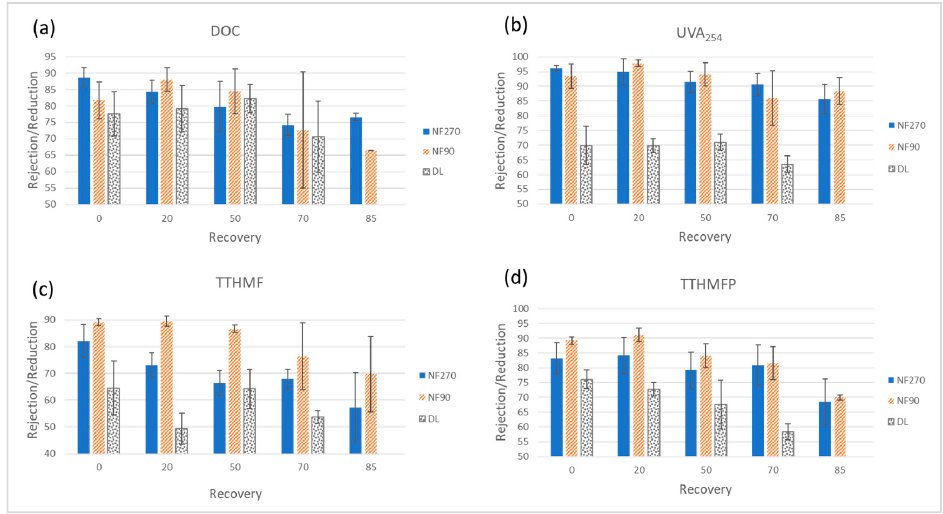
Figure 2. Average reductions in ( a ) DOC, ( b ) UVA 254 , ( c ) TTHMF, and ( d ) TTHMFP for the NF270 (solid blue bars), NF90 (stripped orange bars), and DL (dotted gray bars) membranes as a function of recoveries.